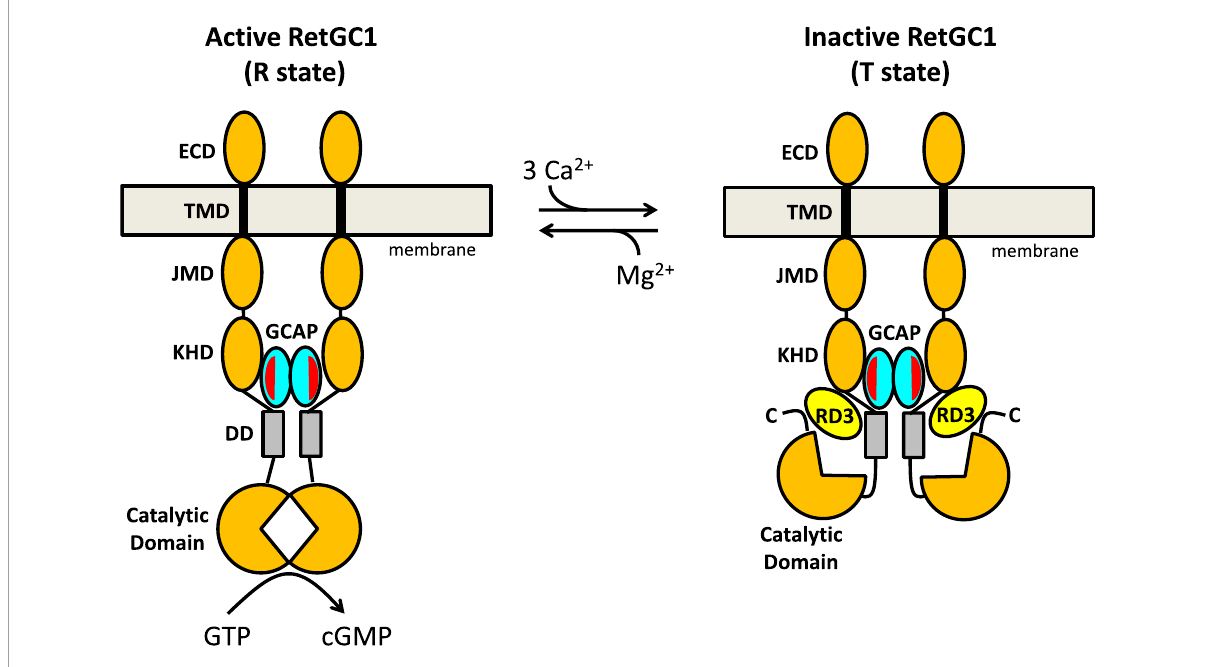
FIGURE4 Schematic model of RetGC1 (orange) regulation by GCAP1 (cyan) and RD3 (yellow). Abbreviations of RetGC1 domains: ECD, extracellular domain; TMD, transmembrane domain; JMD, juxtamembrane domain; KHD, kinase homology domain; DD, dimerization domain (gray). The exposed hydrophobic patch in GCAP1 is